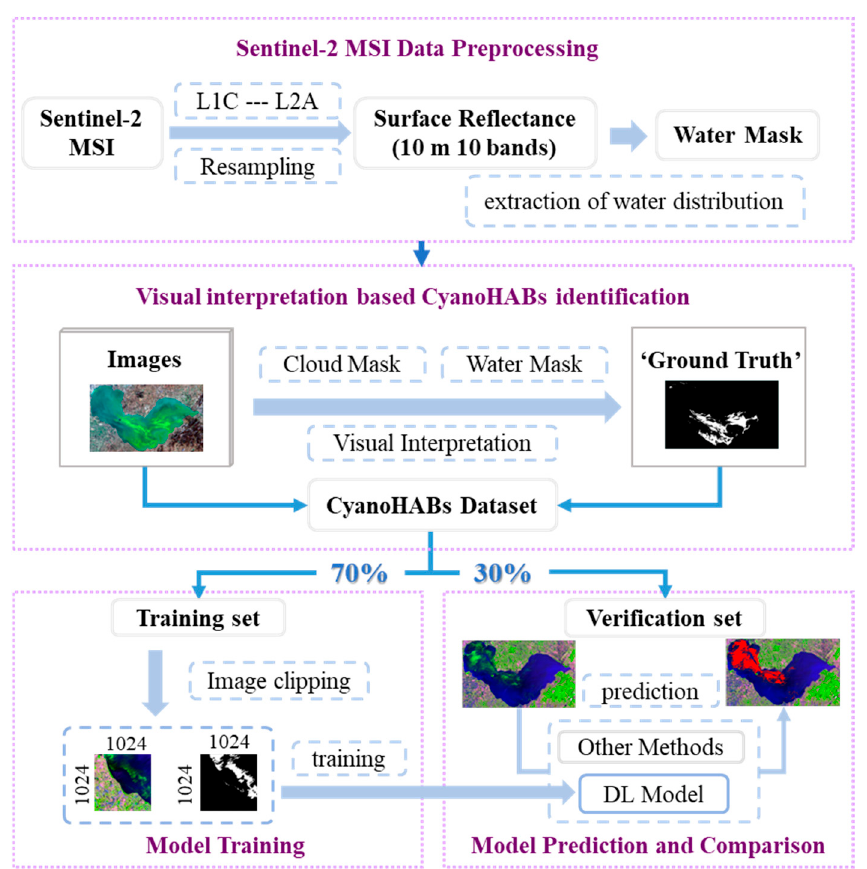
Figure 3. Overall technical process of CyanoHABs extraction based on DL network.